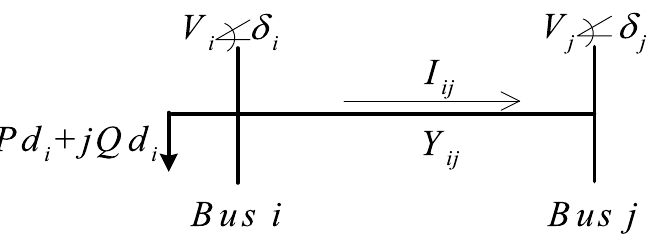
Figure 1. Simplified single-line diagram of the Distribution System